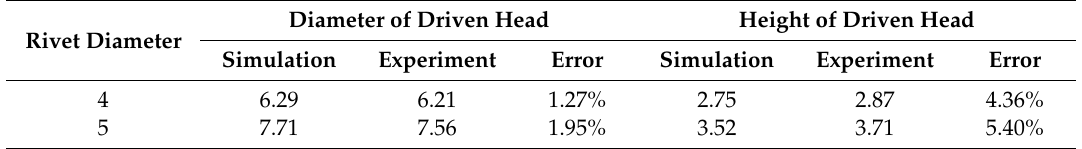
Table 6. The driven head dimensions obtained from experimental results (unit: mm). Rivet Diameter Diameter of Driven Head